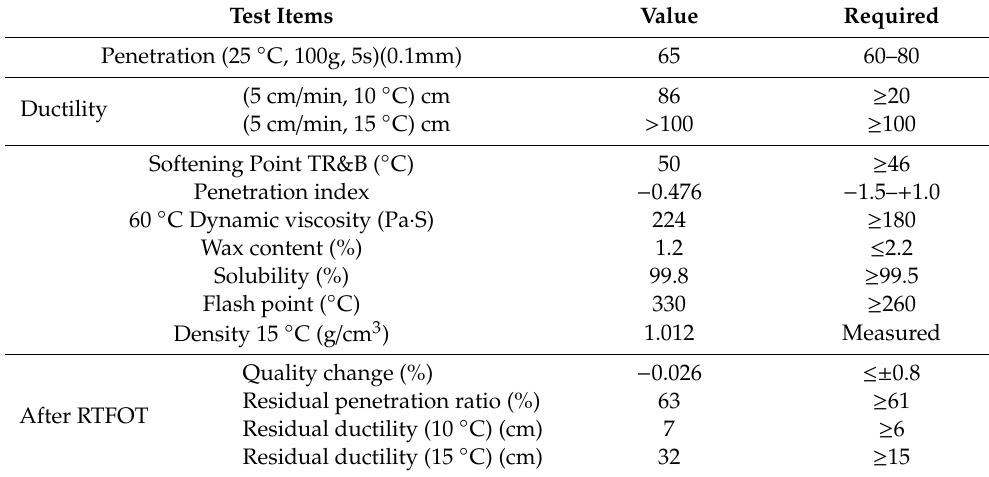
Table 1. Physical Properties of 70# matrix asphalt.